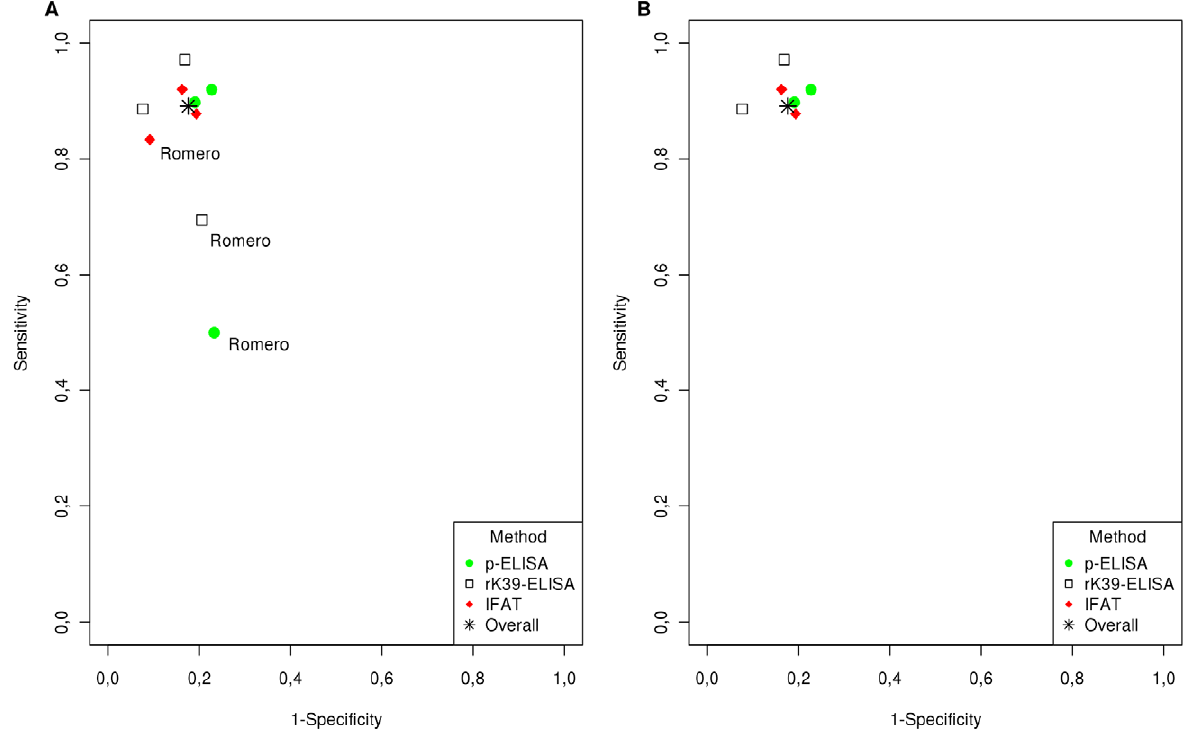
Figure 3. ROC plot comparing the performance of the rK39-ELISA to the p-ELISA and IFAT for the diagnosis of Visceral Leishmaniasis. ( A ) Analysis including all studies that met our selection criteria. ( B ) Analysis after removal of the outlier study.